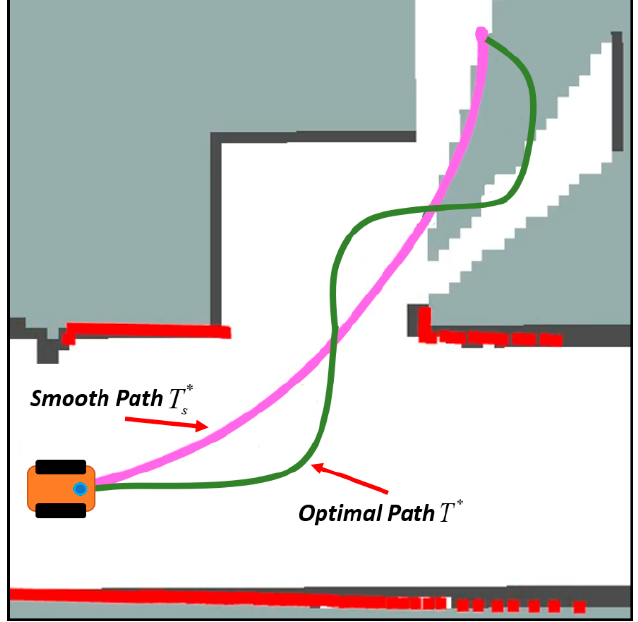
Figure 5. Schematic diagram of path smoothing process. To achieve a smoother motion than the reactive local planning method, we use the nonlinear MPC method [49] to implement the path following of the differential robot. When the robot is close to the target point, we can design the robot’s reference speed using a trapezoidal acceleration and deceleration algorithm. Otherwise, the robot’s reference speed will be set to its maximum speed. When the angle between the robot’s current orientation and the initial part of the path is larger than θ Max , the robot stops and adjusts the orientation to ensure accurate tracking of the